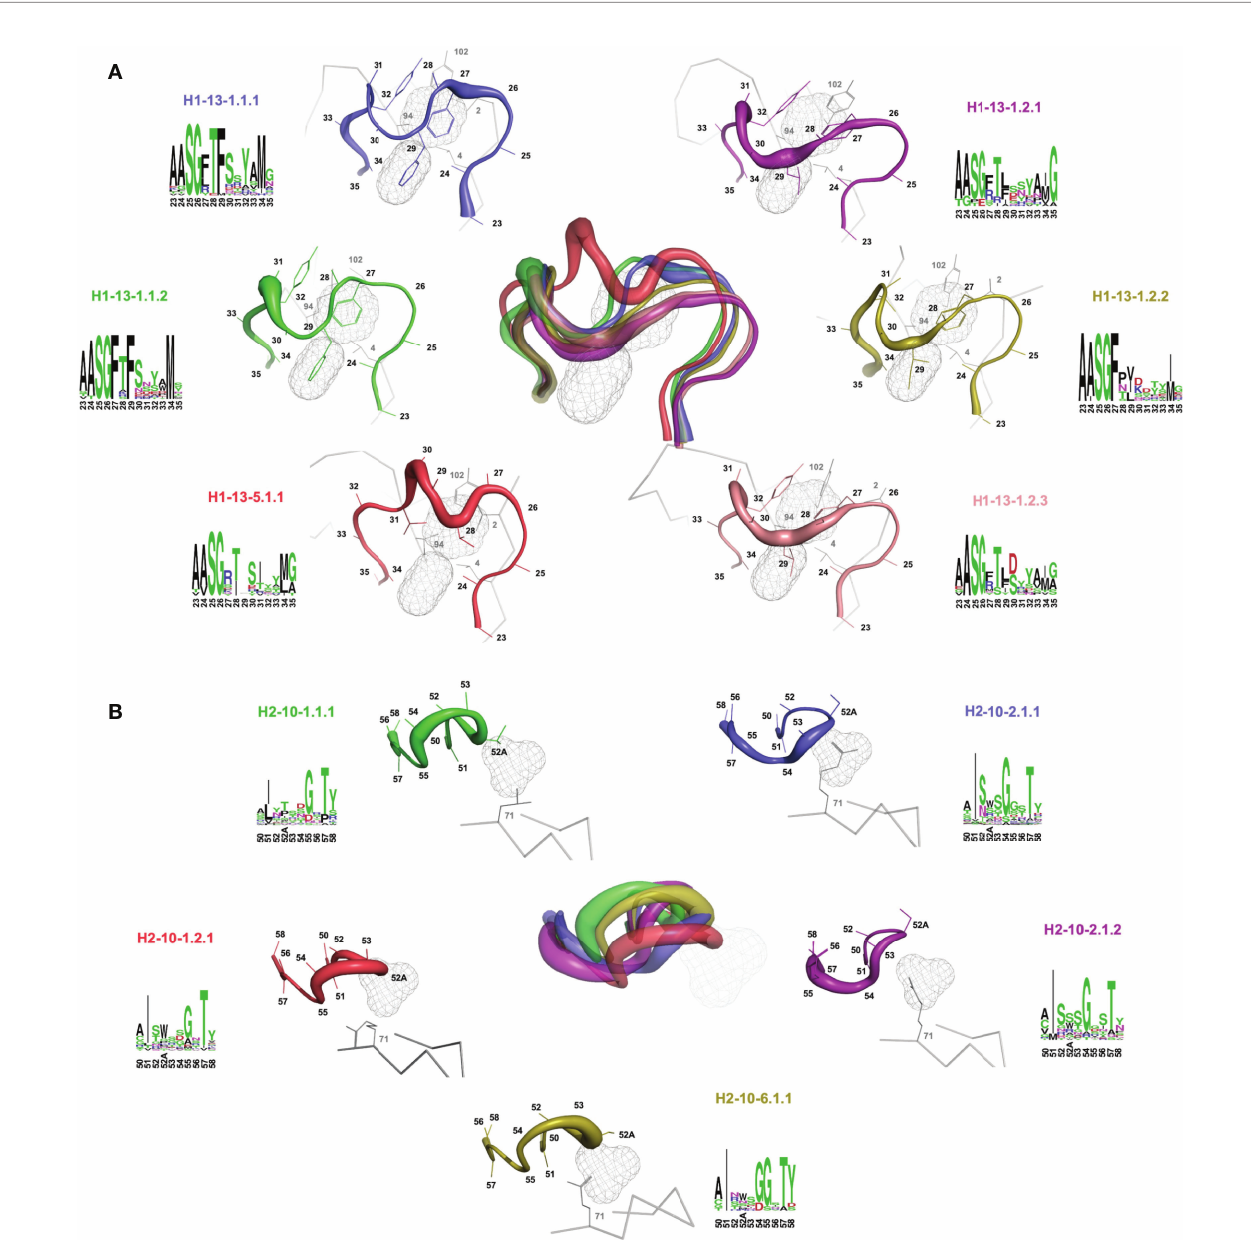
FIGURE 3 | Rendering of the major topological variants for CDR-H1 (A) and CDR-H2 (B) for single-domain antibodies. CDR-H1 is displayed in the presence of pockets P2 and P3, and CDR-H2 in the presence of pocket P1 and residue at FR3 position 71. A superposition view depicts structural differences between the variants. The variants are uniquely colored and displayed individually as sausage views around their centroid structure (see Table 1 ). The centroid structures were superimposed based on the set of backbone framework atoms. The thickness of the sausage is indicative of the structural fl uctuations among cluster members. Each variant is shown with its associated sequence logo with colors denoting the nature of the amino